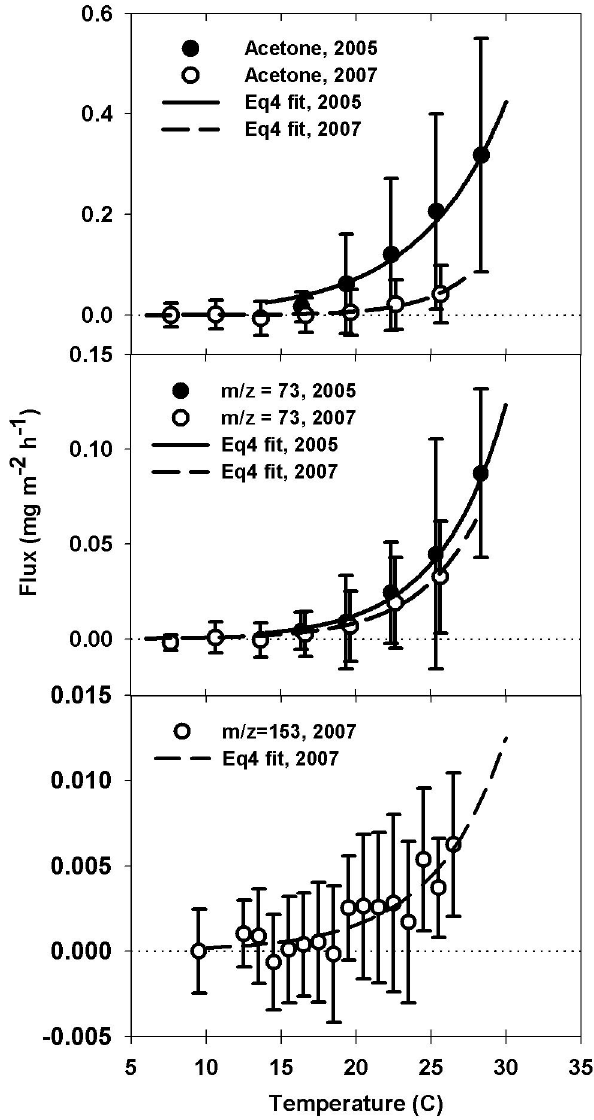
Fig. 10. Binned average fluxes of acetone, m / z =73, and m / z =153 during 2007 as a fucntion of temperature. For m / z =153, only the summer (JJA) of 2007 data is used. Error bars represent 1 standard deviation. Also shown are exponential fits to the data using Eq. (4) and the parameters for each species given in Table